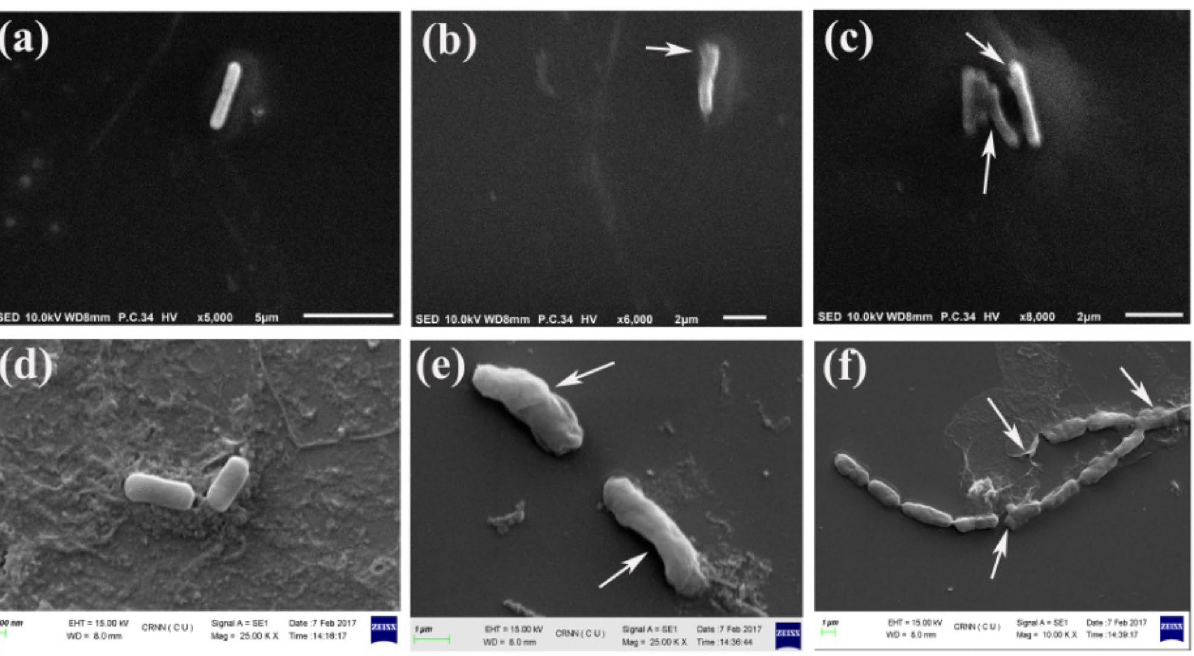
Figure 5. SEM photomicrographs of B. cereus and E. coli cells treated with a 5-butyl-2-pyridine carboxylic acid. ( a , d ) Untreated control cells of B. cereus and E. coli (magnification: × 5000, × 2500 K, respectively); ( b , c ) treated B. cereus cells after 30 min and after 3 h incubation (magnification: × 6000, × 8000, respectively). ( e , f ) treated E. coli cells after 30 min and 3 h incubation (magnification: × 2500 K, × 1000 K, respectively). The significant morphological changes have been marked with white